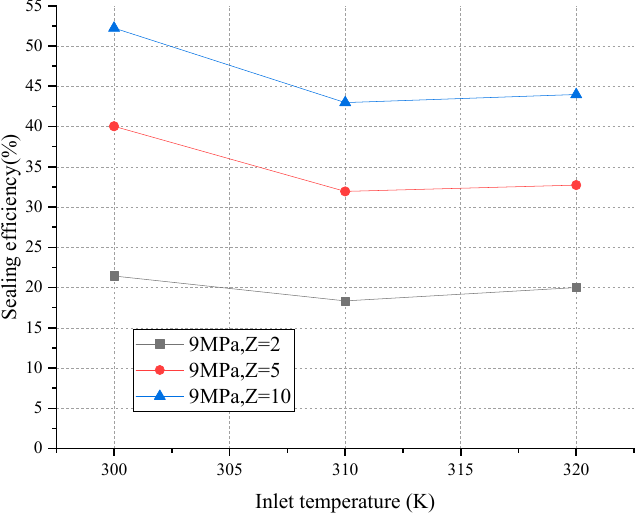
Figure 25. The e ff ect of teeth number Z on sealing e ffi ciency. Figure 25. The effect of teeth number Z on sealing efficiency. Figure 25. The effect of teeth number Z on sealing efficiency.